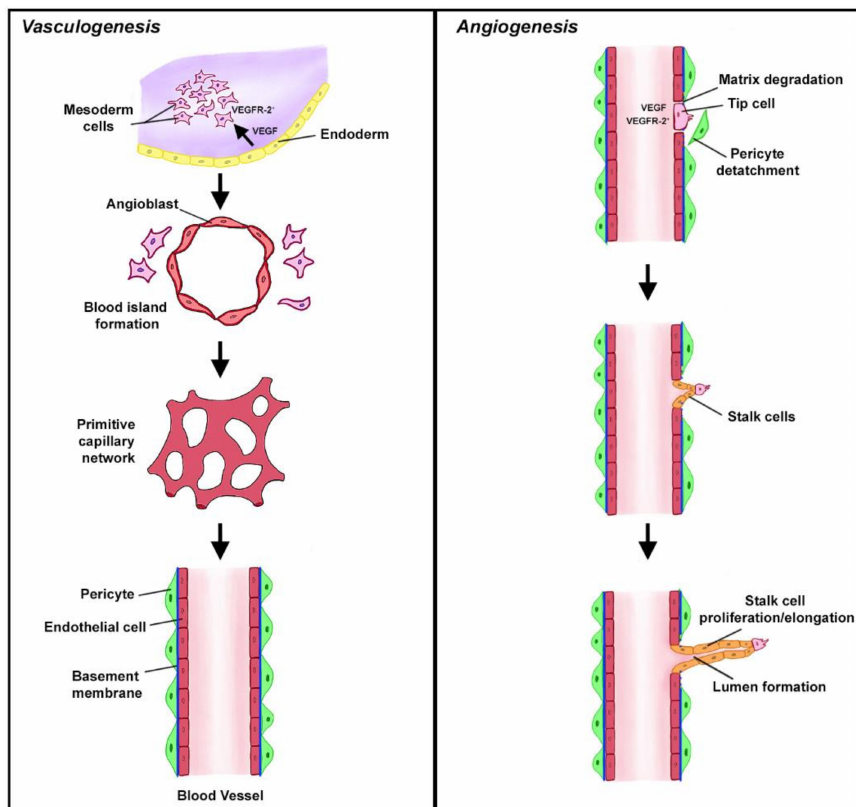
Figure 1. Vasculogenesis vs. angiogenesis. Vasculogenesis in embryos ( left ) is the de novo creation of new vasculature from primitive mesodermal cells that express VEGFR2. VEGF released from neighboring endodermal cells converts these VEGFR2 + cells into angioblasts surrounding the blood islands. These islands fuse to form the primitive vascular network that eventually converts into the arteriovenous system. In contrast, angiogenesis ( right ) is a formation of new vessels from the existing vasculature. The initial steps involve degradation of the extracellular matrix (ECM), detachment of pericytes, and tip formation. The non-proliferating tip endothelial cells move toward proangiogenic factors and are followed by dividing stalk cells. These drawings are based on the figures included in